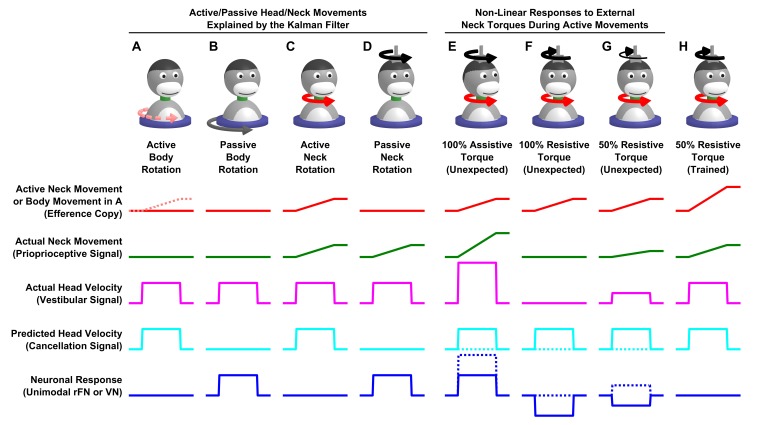
Neuronal responses when perturbing motor activity during active movement.This figure recapitulates neuronal responses (VN and unimodal rFN neurons encoding passive head rotations) during various combinations of passive and active whole body or neck rotation, and corresponding sensory and motor variables. (A-D) Movements modeled in Figure 7 and Figure 7—figure supplement 1–5, where neurons encode the difference between the vestibular rotation signal (magenta) and a cancellation signal (cyan), which in the Kalman filter model is interpreted as a predicted vestibular signal based on efference copies of neck (red lines and arrows) or body (in A; pink broken line and arrow) motor commands. (E-H) Here, assistive or resistive torques are applied during an active neck movement, increasing or preventing the actual neck rotation (magenta). If responses were additive (solid lines), protocols E and F would be equivalent to (C + D) and (C-D), respectively, and neuronal firing rate would encode the head rotation component generated by the passive torque. In contrast, Roy and Cullen (2004) and Brooks and Cullen (2014) showed that VN neurons encode net head velocity (broken line), indicating that the process of transforming motor commands into a cancellation signal stops. Similarly, Brooks et al. (2015) applied a resistive torque during active head movements and found that, early in the experiments, rFN encoded net head velocity (G, broken line). They also found that the animals learned to compensate for the torque, at which point rFN neurons responses were again suppressed (H). Together, these results indicate that a mismatch between expected and actual head proprioception occurring during active neck movements results in a non-additive response that has been modeled by a non-linear ‘switching’ mechanism (Roy and Cullen, 2004). In contrast, vestibular mismatches do not induce any non-linear interactions, at least in the ensemble of stimuli considered here.